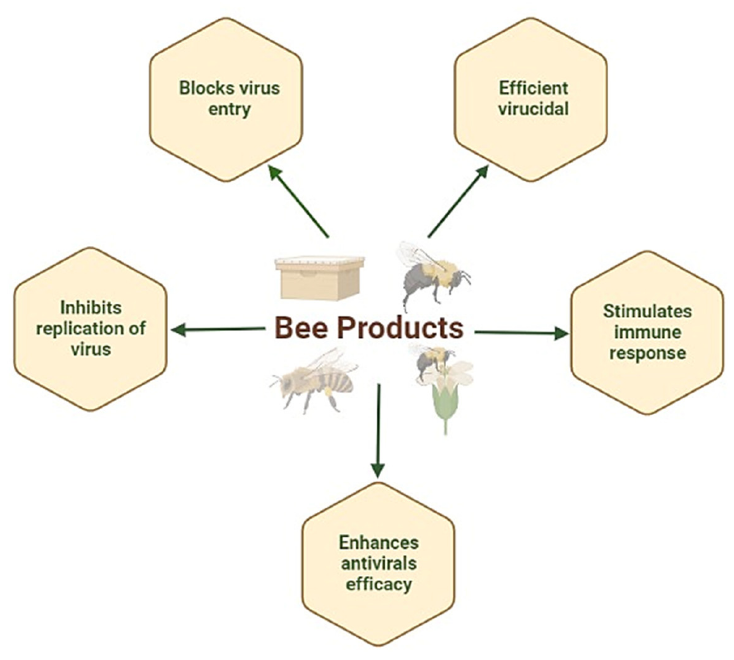
Figure 1. Antiviral properties of bee products.